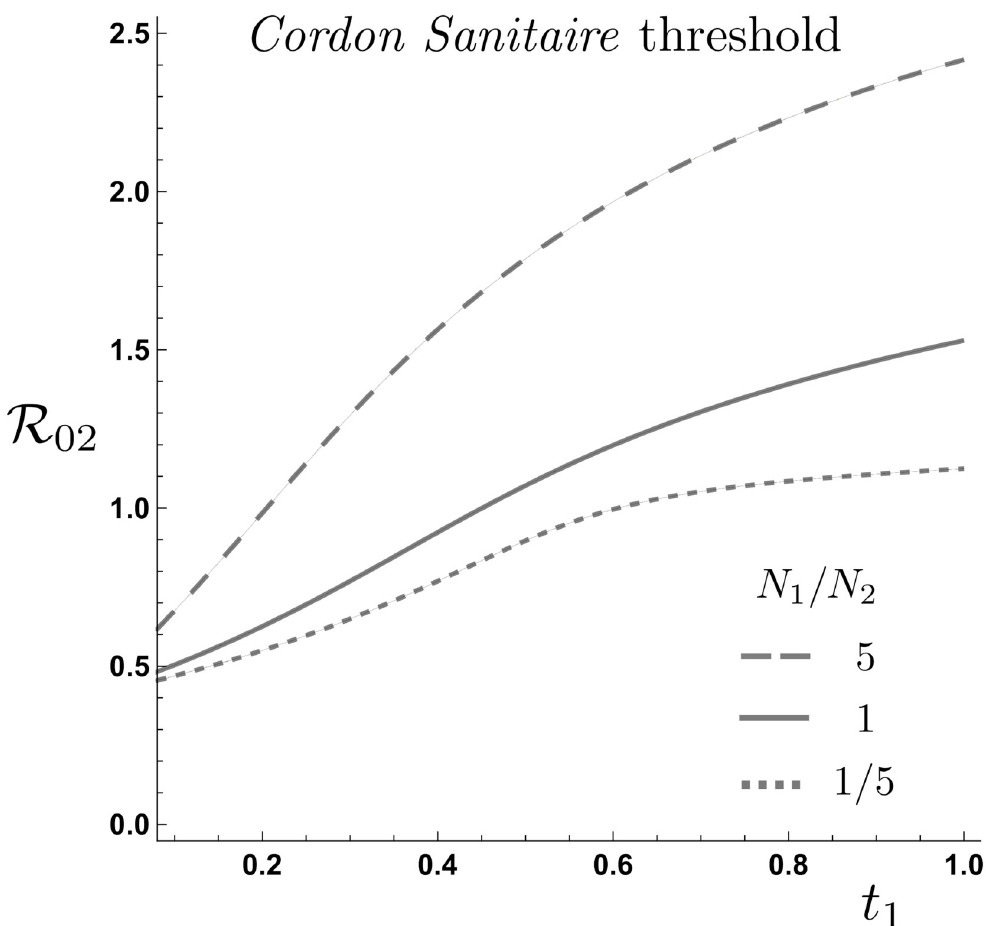
Fig 5. Cordon sanitaire level curves for population density ratios N 1 minimum mobility level required to drop the total attack rate below the cordon sanitaire under unidirectional mobility from the HRC.